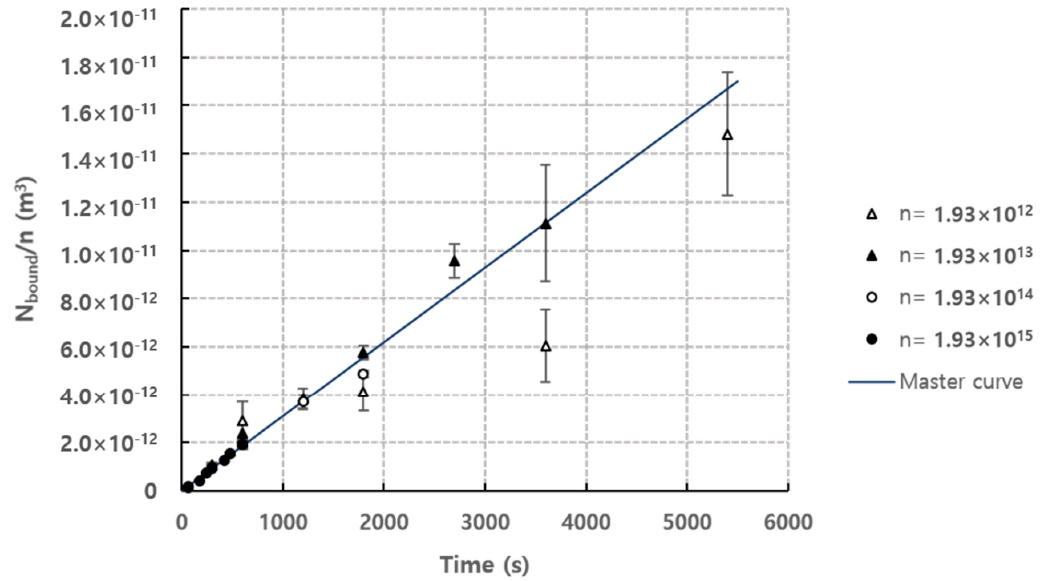
Figure 7. Normalized N bound according to the time for each concentration (Normalized by number density n ), flow rate = 1.2 mL · h − 1 , observation position = 35 mm. Master curve was fitted using the least square method ( R 2 = 0.90 ).